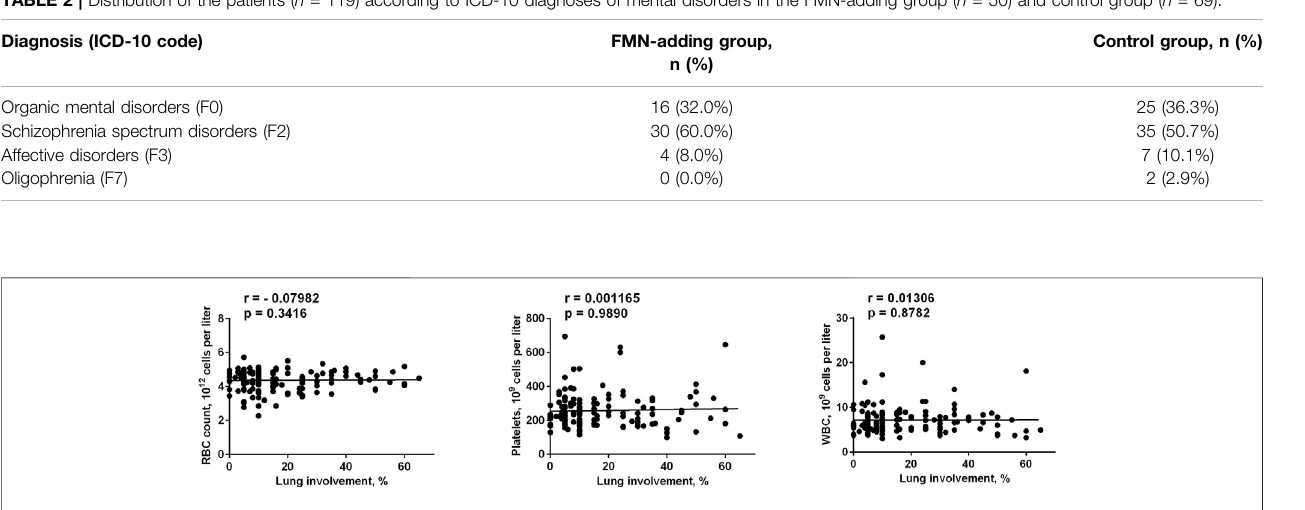
Table 3 . Neutrophils and lymphocytes counts, as well as their ratio, provide the most promising data for the correlation between the COVID-19 course and FMN supplementation.